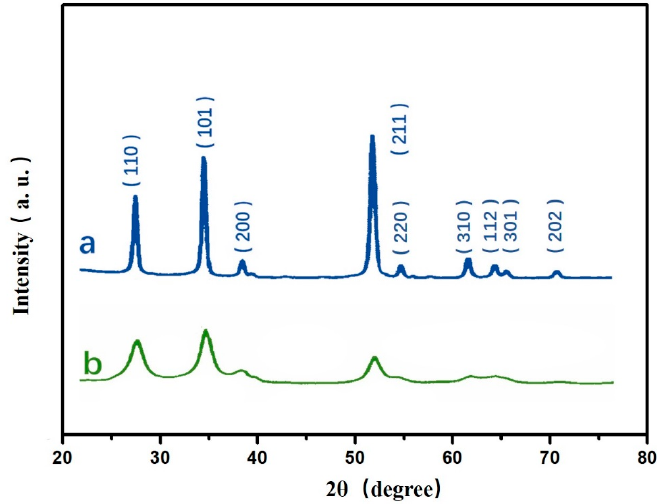
Figure 2. The XRD patterns of SnO 2 nanostructure film. (a) The SnO 2 after thermal annealing; (b) as-